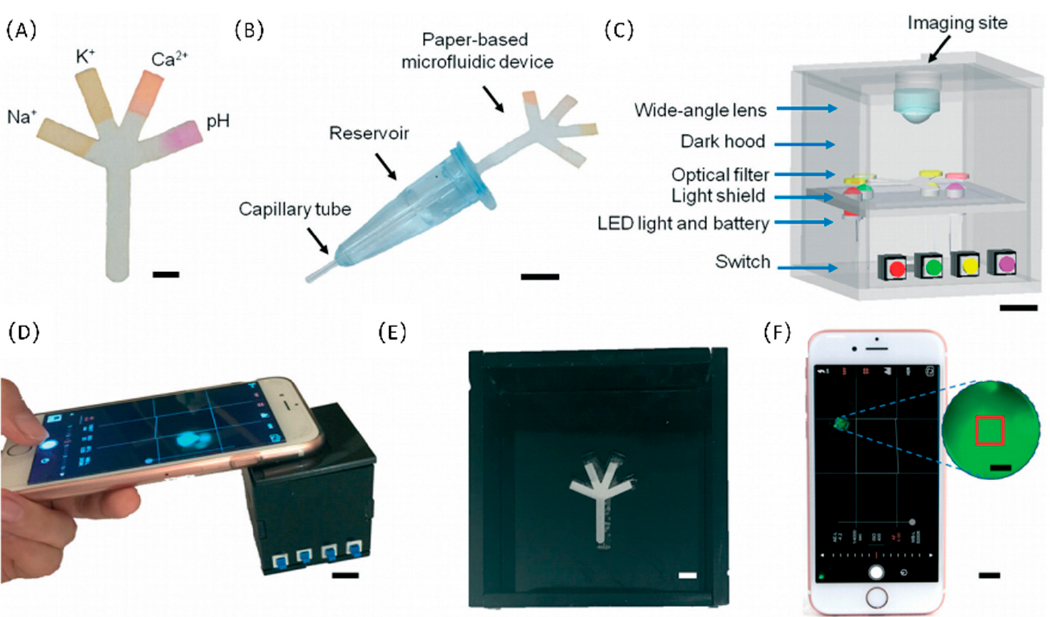
Figure 3. Measurement of electrolytes in tears by a paper-based integrated microfluidic system and data acquisition with a smartphone. ( A ) Paper-based microfluidic device impregnated with fluorescent probe. ( B ) Samples were collected and diluted using capillary tubes. ( C ) The schematic diagram of the portable readout device. ( D ) The use of the portable readout device in combination with a smartphone to capture the image of the fluorescent probes. ( E ) Photograph of the interlayer groove used to place the paper-based microfluidic device. ( F ) Screenshots of smartphone applications that capture the measured images. Reprinted with permission from [62]. Copyright 2017 Royal Society of Chemistry.